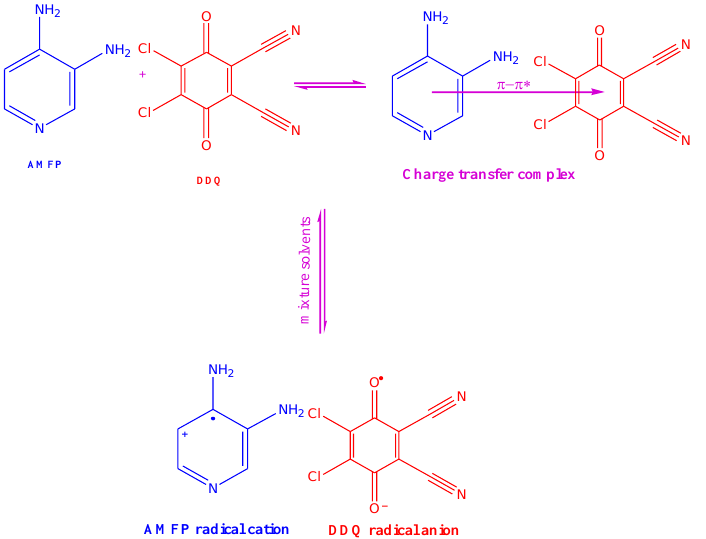
Scheme 1. The suggested reaction of AMFP with DDQ in a polar/nonpolar mixture system.